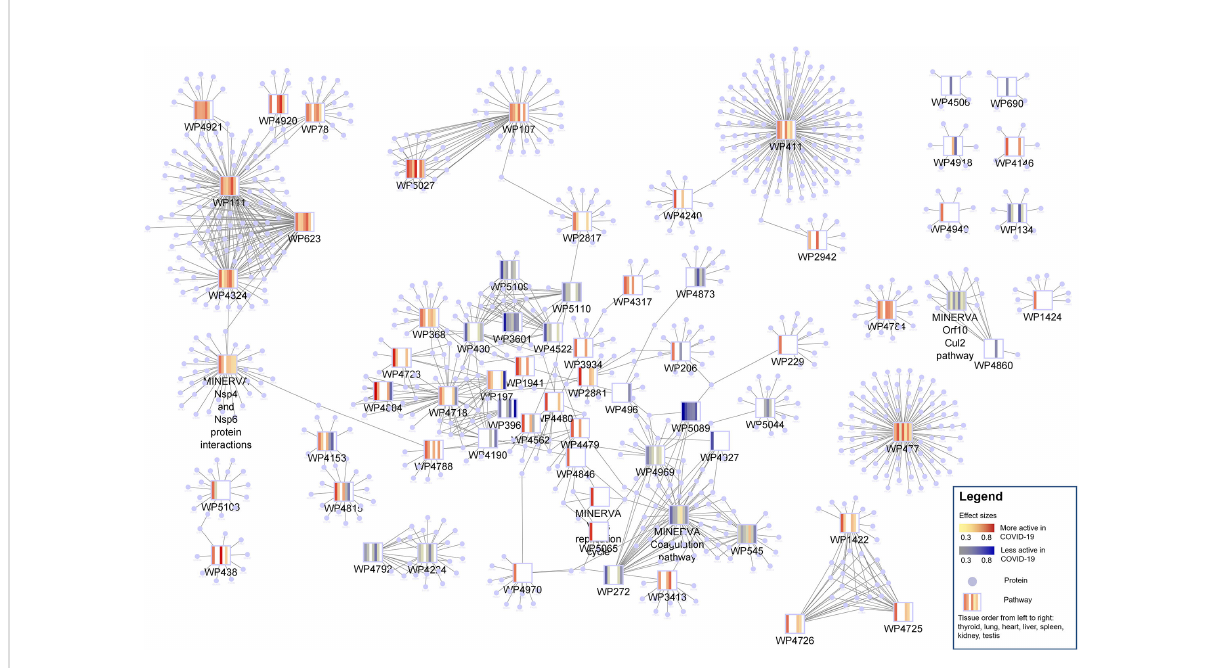
FIGURE 3 Protein-pathway network of 69 changed pathways in COVID-19 patients. Pathways are shown as rectangles and the proteins present in a pathway are connected to the pathway node and shaped as circles. The pathway nodes visualize the heatmap of pathway activity change in COVID-19 patients from thyroid, lung, heart, liver, spleen, kidney and testis in that order. Blue indicates a lower pathway activity in COVID-19 patients (protein abundance distribution shifted to the left) and red indicates an increased activity (protein abundance distribution shifted to the right). Most of the pathways are highly connected with many proteins in